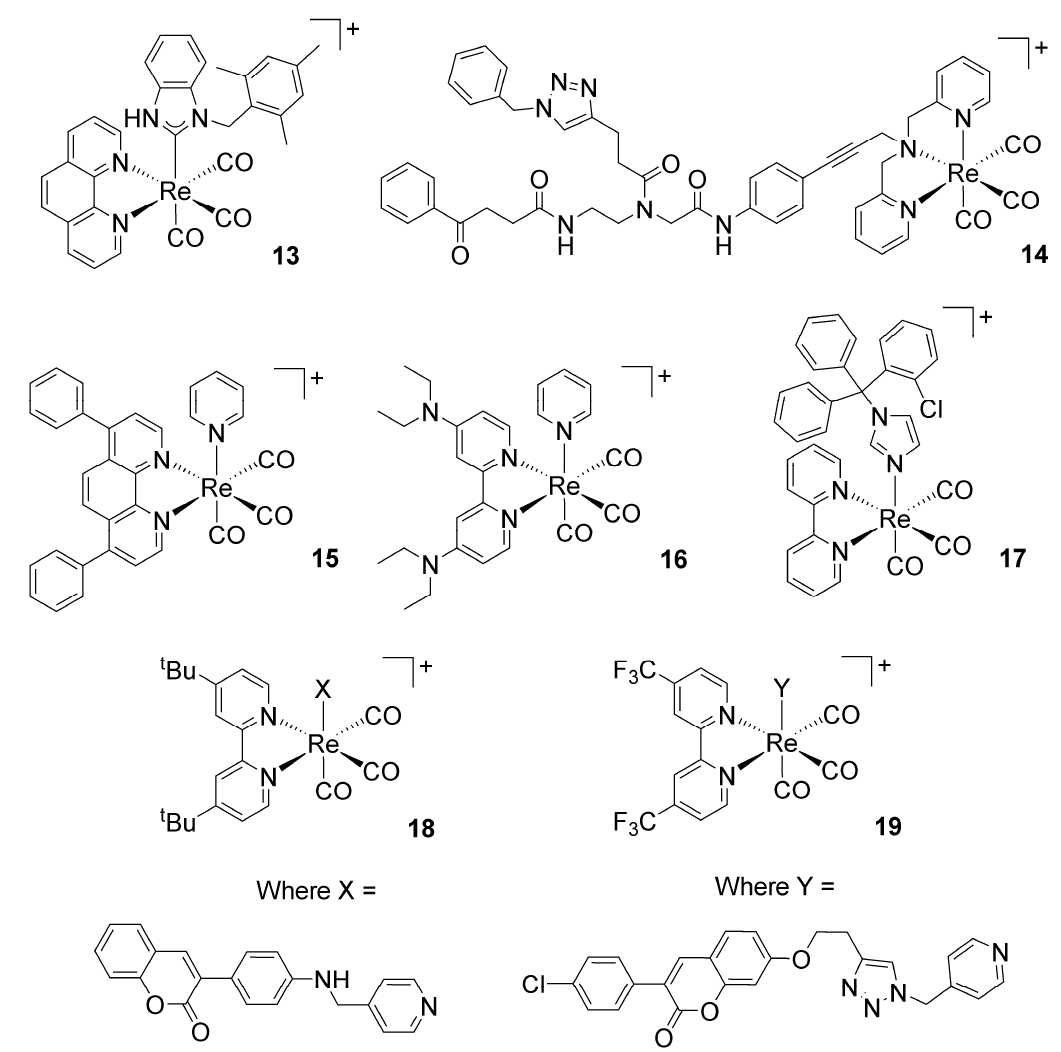
+ complexes. Complex 13 [32]; 3 ]